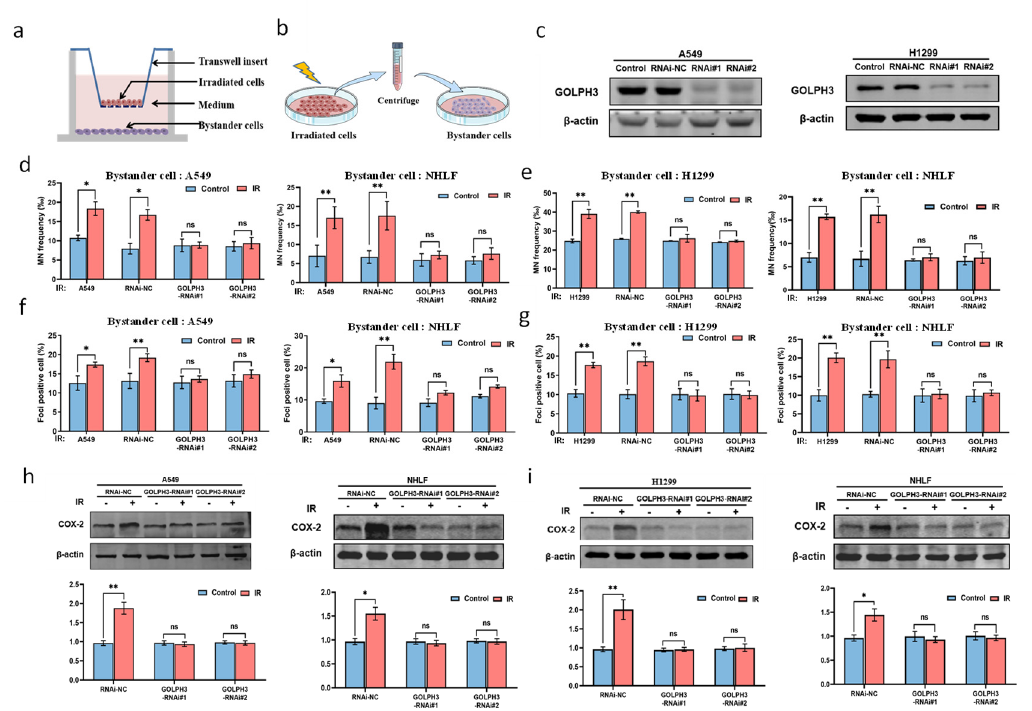
Figure 1. GOLPH3 in the irradiated cells mediates the occurrence of RIBE. ( a ) Transwell co-culture system; ( b ) model of conditioned medium transfer; ( c ) knockdown of GOLPH3 validated by Western blotting in A549 and H1299 cells; ( d ) MN yields in the bystander cells (A549 or NHLF) after co-culture with the irradiated A549, A549/RNAi-NC or A549/GOLPH3-RNAi cells, respectively; ( e ) MN yields in the bystander cells (H1299 or NHLF) after co-culture with the irradiated H1299, H1299/RNAi-NC and H1299/GOLPH3-RNAi cells, respectively; ( f ) quantification of γ -H2AX positive cells in the bystander cell population (A549 or NHLF) after 3 h co-culture with the irradiated A549, A549/ RNAi-NC and A549/GOLPH3-RNAi cells, respectively; ( g ) quantification of γ -H2AX-positive cells in the bystander cells (H1299 or NHLF) after 3 h co-culture with the irradiated H1299, H1299/RNAi-NC and H1299/GOLPH3-RNAi cells, respectively; ( h ) representative results of Western blot (upper) and the corresponding quantification (lower) of COX-2 protein in the bystander cells (A549 or NHLF) after 24 h co-culture with irradiated A549/RNAi-NC and A549/GOLPH3-RNAi cells, respectively; ( i ) representative result of Western blot (upper) and the corresponding quantification (lower) of COX-2 protein in the bystander cells (H1299 or NHLF) after 24 h co-culture with the irradiated H1299/RNAi-NC and H1299/GOLPH3-RNAi cells, respectively. *: p < 0.05; **: p < 0.01; ns: not significant.